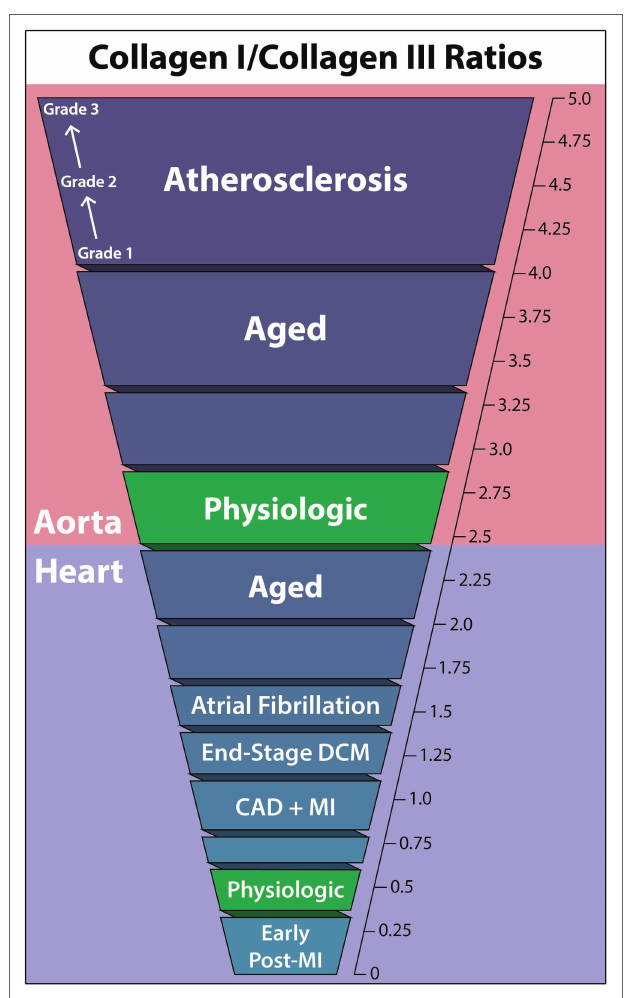
FIGURE 1 | Collagen-I to collagen-III ratios within the human aorta and heart in cardiovascular diseases, the aged individuum, and the physiologic situation. Collagen-I increases relative to collagen-III in all non-physiologic cases other than early post-myocardial infarction, and the aorta is seen to have a much higher collagen-I/collagen-III ratio than the heart in general. DCM, dilated cardiomyopathy; CAD, coronary artery disease; MI, myocardial